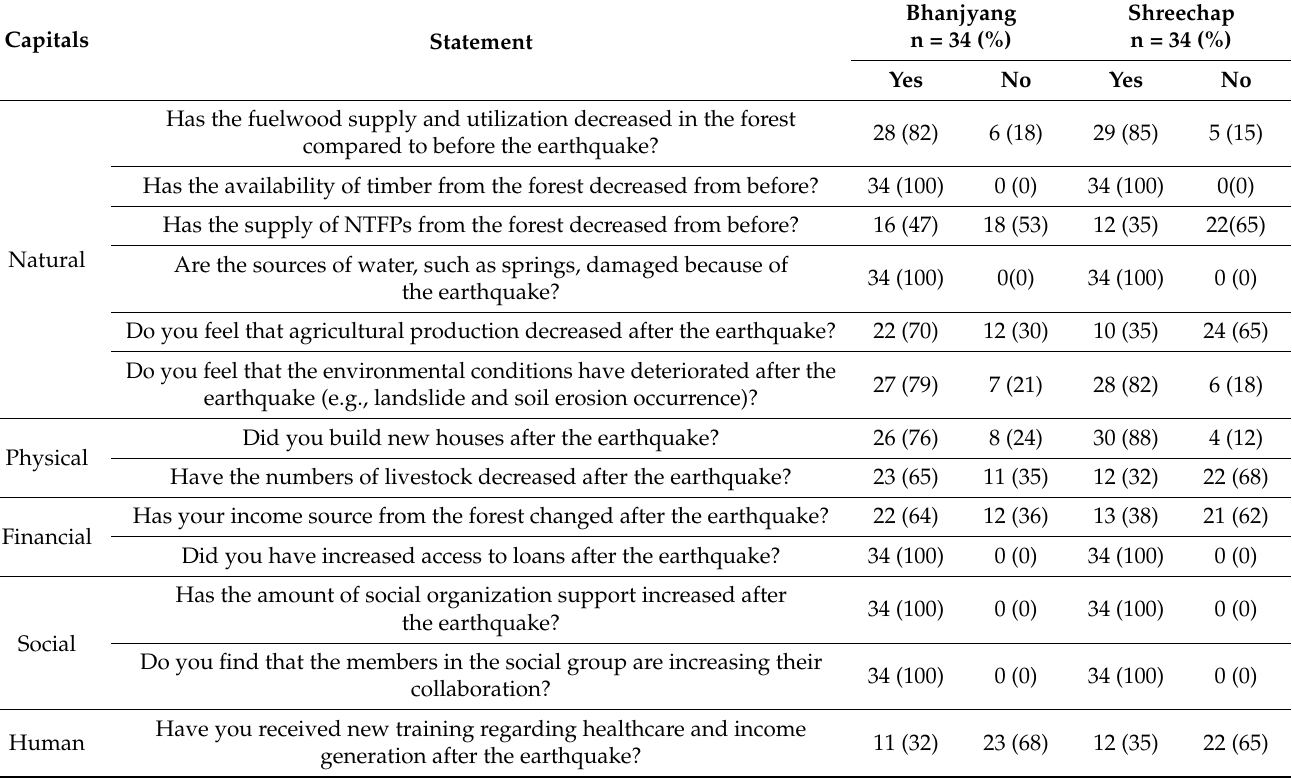
Table 3. Perception of respondents of both CFUGs on livelihood